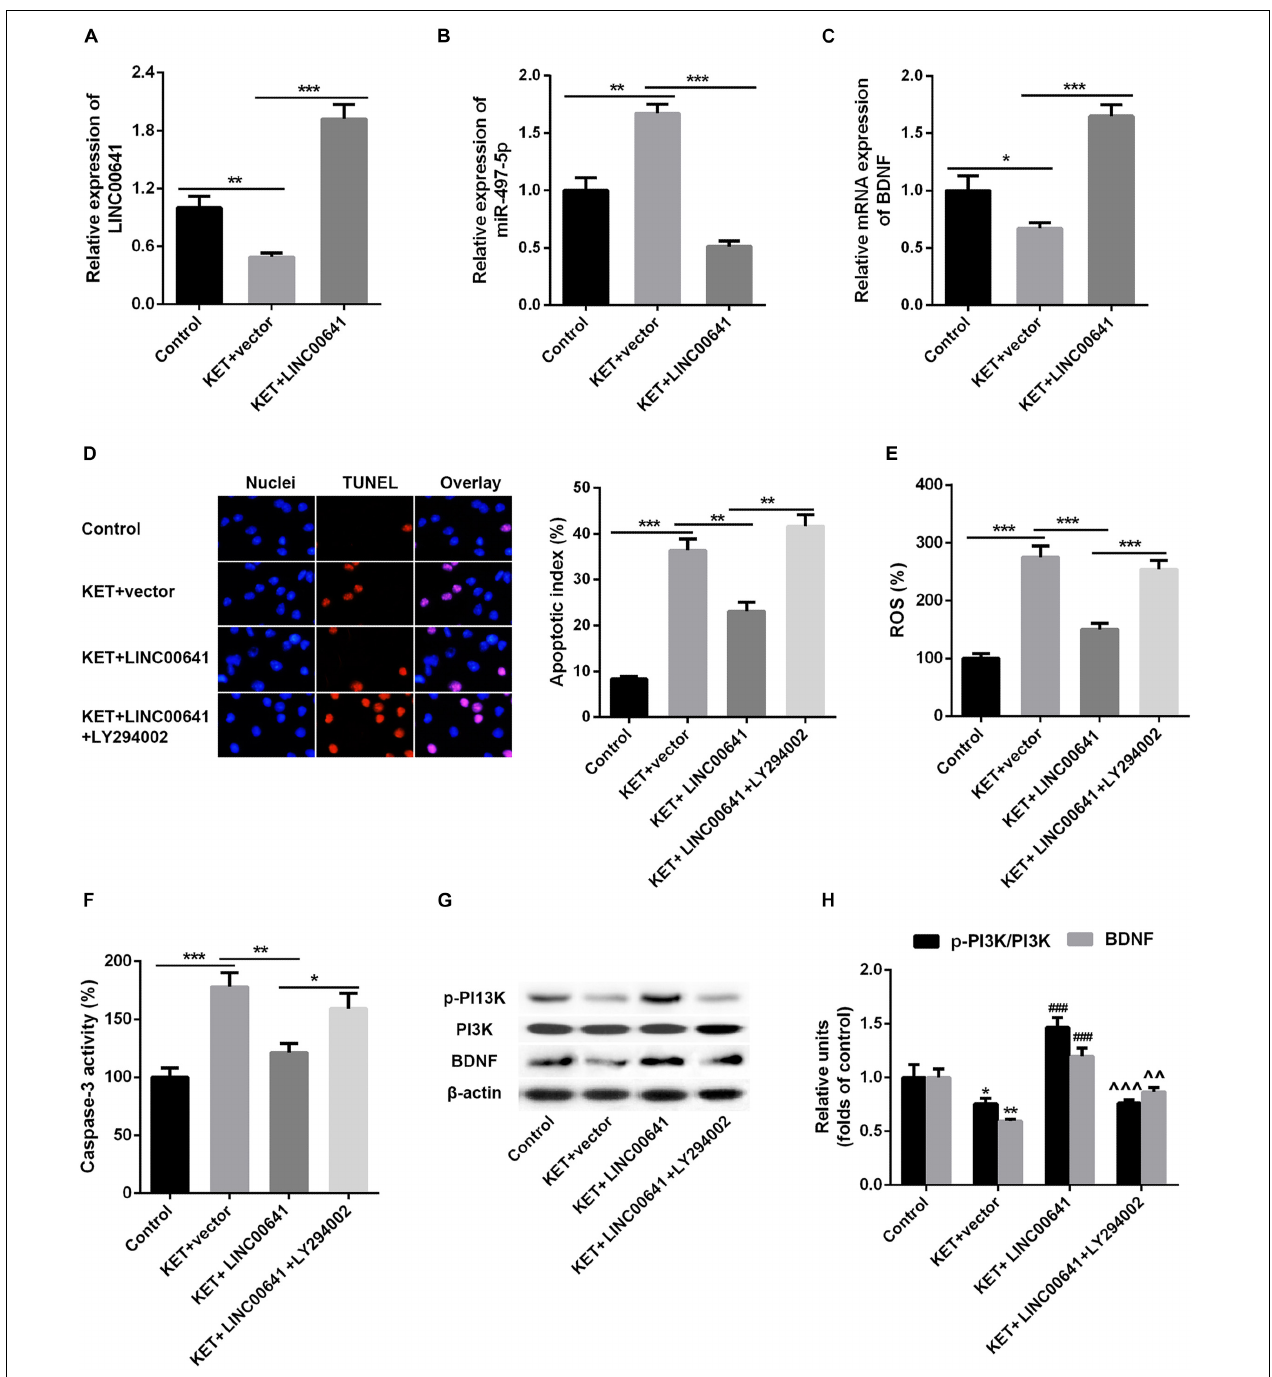
FIGURE 6 | Effect of overexpression of LINC00641 on neuronal injury in rats. (A–C) The expression of miR-497-5p and BDNF mRNA in overexpressing LINC00641 rats was detected by qPCR. (D–F) TUNEL and apoptosis index, ROS level, caspase-3 activity analysis. (G,H) Western blot was used to detect the protein expression and relative protein expression of p-PI3K and BDNF. KET, ketamine. * P < 0.05, ** P < 0.01, and *** P < 0.001 vs. control group. # P < 0.05, ## P < 0.01, and ### P < 0.001 vs. KET + vector group . ∧ P < 0.05, ∧∧ P < 0.01, and ∧∧∧ P < 0.001 vs. KET + LINC00641